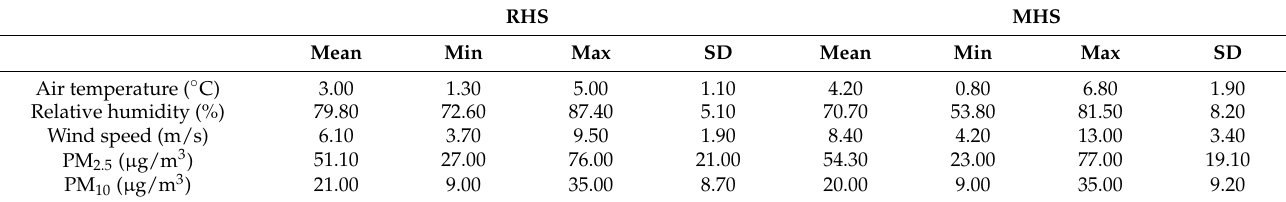
Table 4. Outdoor environment data